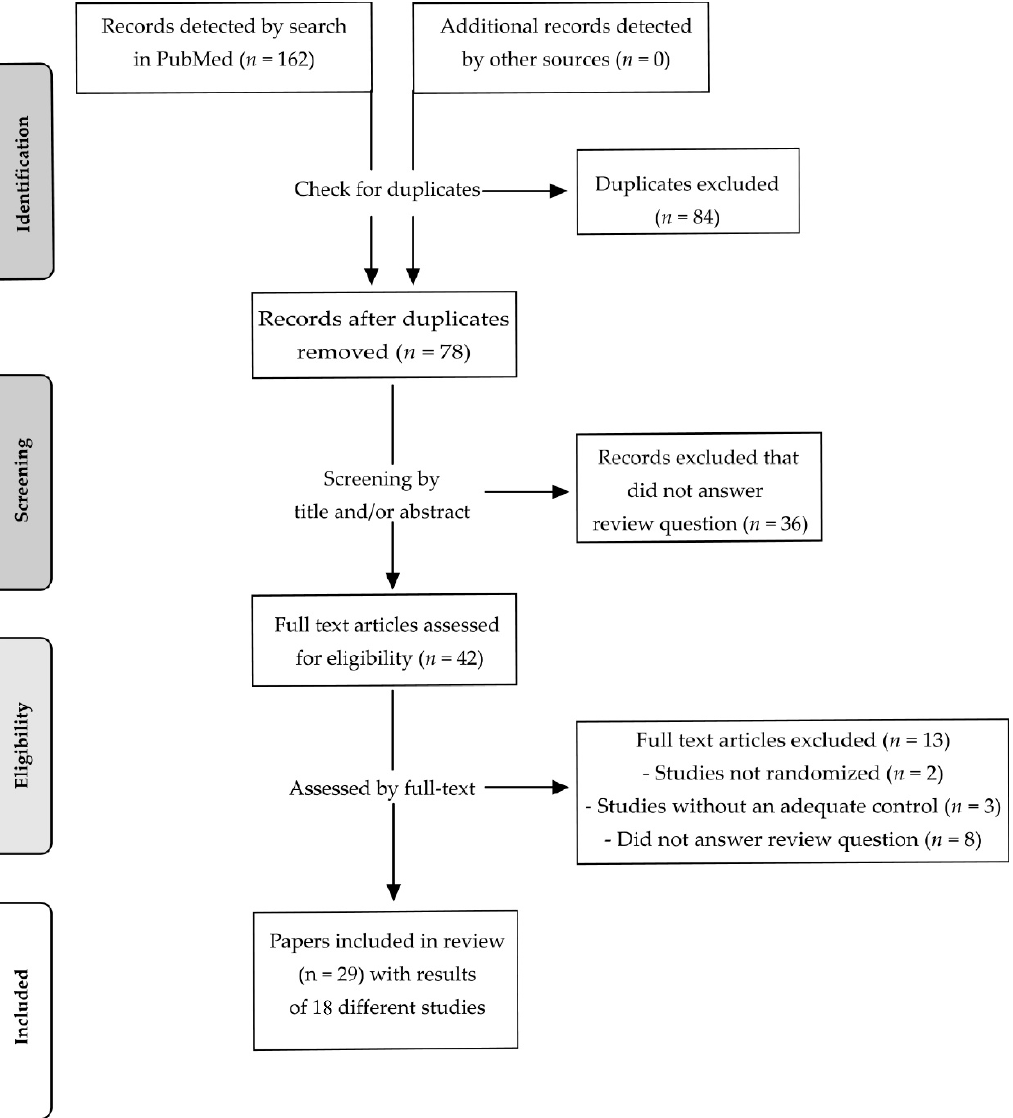
Figure 1. Flow-diagram of study selection process according to PRISMA statement .